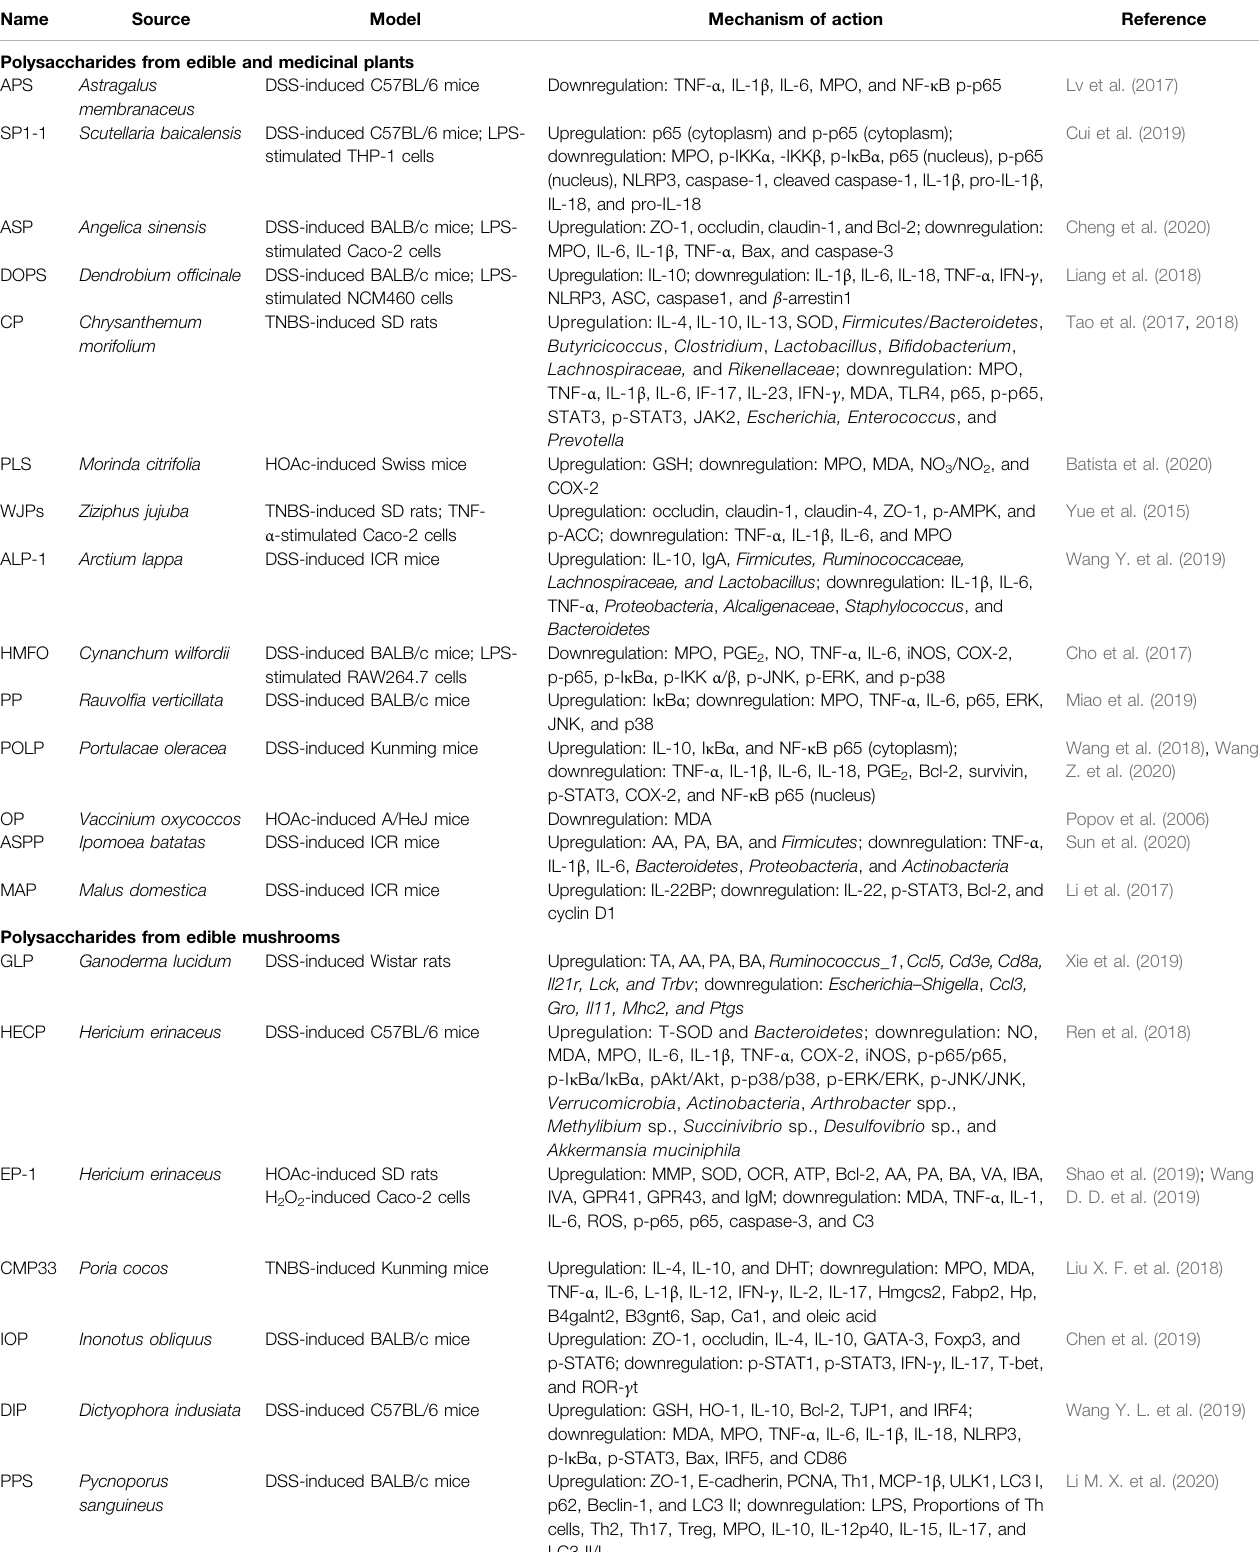
TABLE 3 | Summary of the mechanisms of polysaccharides from natural sources in the treatment of